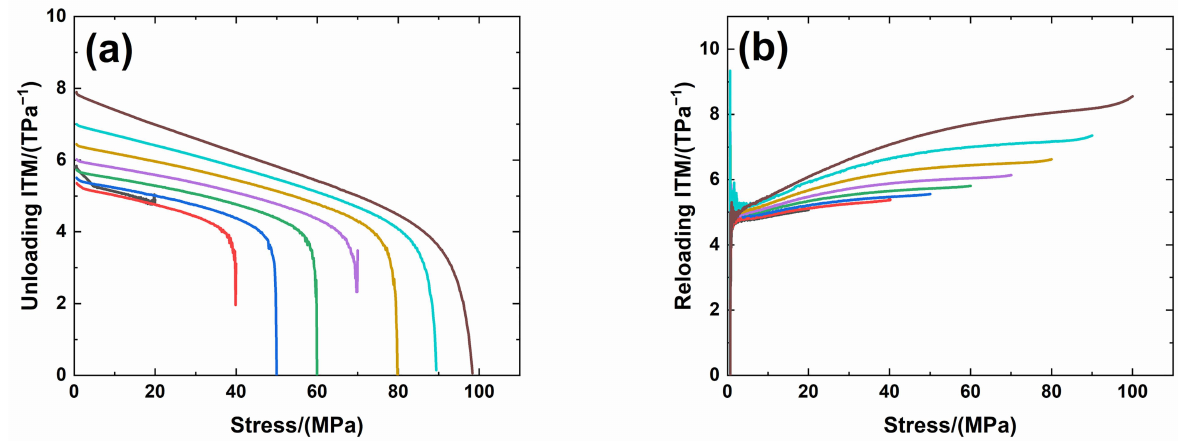
proximately σ uts = 64.4 MPa with the failure strain of approximately ε f = 0.16%, as shown in Figure 6a. For unloading and reloading at the peak stress of σ max = 20, 30, 40, 50 and 60 MPa, the cyclic loading/unloading damage parameters are listed in Table 3. The composite exhibits obvious hysteresis loops, as shown in Figure 6a. The composite residual strain, ε res , increases from ε res = 0.0003% at σ max = 20 MPa to ε res = 0.03% at σ max = 60 MPa, as shown in Figure 8a; the composite peak strain, ε p , increases from ε p = 0.0158% at σ max = 20 MPa to ε p = 0.113% at σ max = 60 MPa, as shown in Figure 8b; the composite hysteresis width, ∆ ε , increases from ∆ ε = 0.0016% at σ max = 20 MPa to ∆ ε = 0.017% at σ max = 60 MPa, as shown in Figure 8c; and the composite hysteresis dissipated energy, Σ , increases from Σ = 0.18 kPa at σ max = 20 MPa to Σ = 10.5 kPa at σ max = 60 MPa, as shown in Figure 8d. Upon un- loading at peak stress σ max = 20 MPa, the composite unloading ITM increases rapidly from ITM = 2.3 TPa − 1 at σ max = 20 MPa to ITM = 6.05 TPa − 1 at σ = 18.4 MPa, and then increases slowly to ITM = 7.9 TPa − 1 at σ = 0.5 MPa, as shown in Figure 9a; upon reload- ing, the composite reloading ITM increases rapidly from ITM = 3.2 TPa − 1 at σ = 0.5 MPa to ITM = 6.1 TPa − 1 at σ = 1.8 MPa, and then increases slowly to ITM = 7.9 TPa − 1 at σ max = 20 MPa, as shown in Figure 9b. Upon unloading at peak stress σ max = 60 MPa, the composite unloading ITM increases rapidly from ITM = 0.27 TPa − 1 at σ max = 60 MPa to ITM = 6.69 TPa − 1 at σ = 51.7 MPa, and then increases slowly to ITM = 13.6 TPa − 1 at σ = zero MPa, as shown in Figure 9a; upon reloading, the composite reloading ITM increases rapidly from ITM = 4 TPa − 1 at σ = 0.6 MPa to ITM = 7.5 TPa − 1 at σ = 3.7 MPa, and then increases slowly to ITM = 14.5 TPa − 1 at σ max = 60 MPa, as shown in Figure 9b.